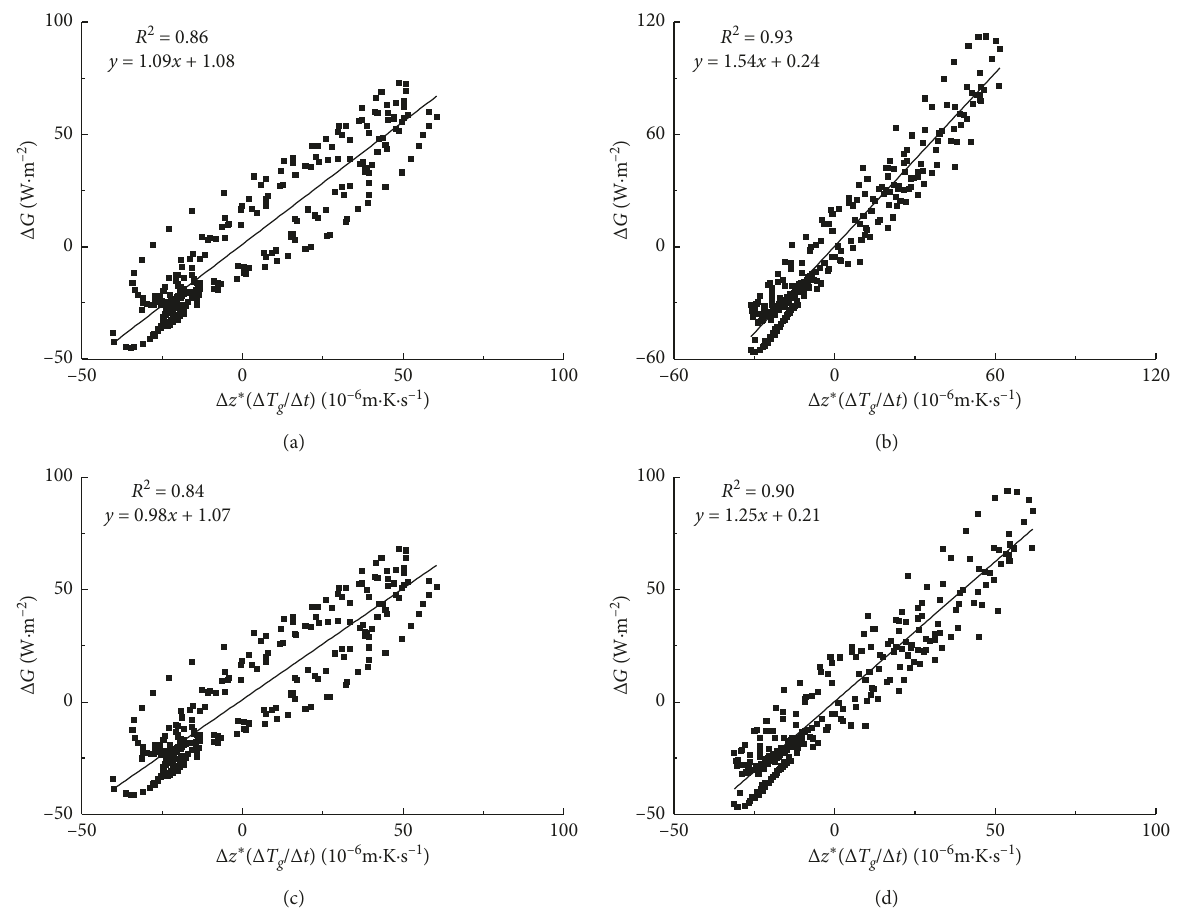
Figure 6: Variations in the soil thermal capacity before and after rainfall: (a) water-bearing soil before rainfall; (b) water-bearing soil after rainfall; (c) water-free soil before rainfall; (d) water-free soil after rainfall.